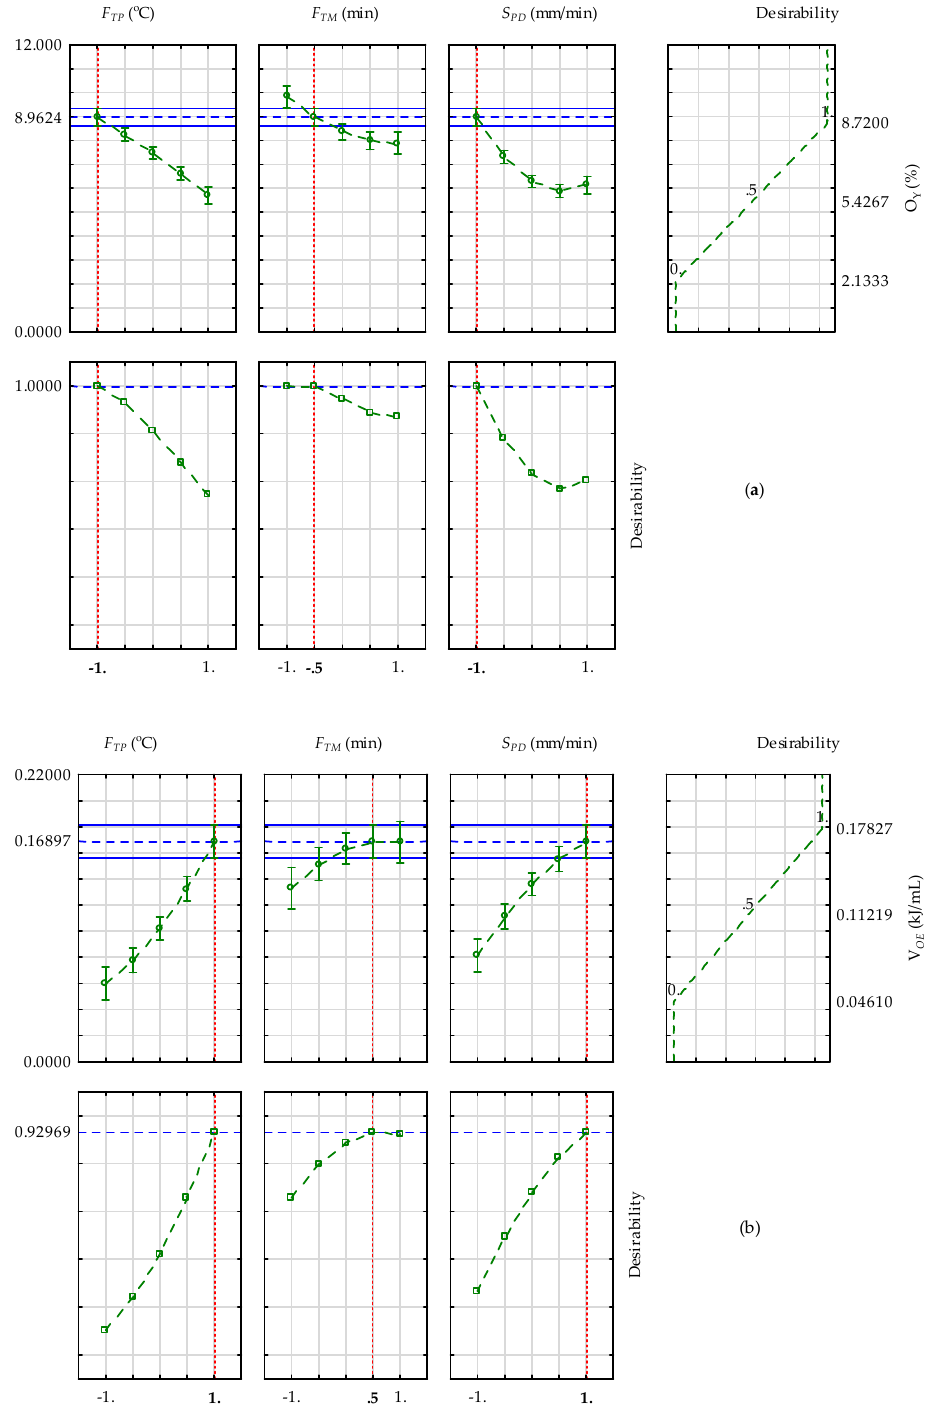
Figure 7. Predicted values and desirability of ( a ) O Y , oil yield, and ( b ) V OE , volume of oil energy under heating temperatures ( O Y : F TP : − 1 = − 2 ◦ C; F TM : − 0.5 = 22.5 min and S PD : − 1 = 5 mm/min; V OE : F TP : +1 = − 36 ◦ C; F TM : +0.5 = 37.5 min and S PD : +1 = 15